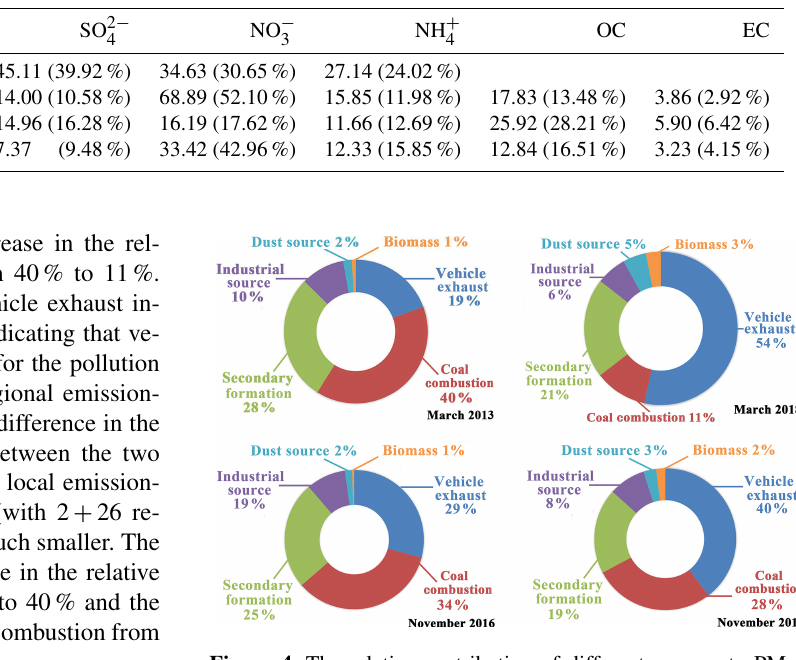
Figure 4. The relative contribution of different sources to PM 2 . 5 concentrations in Beijing during four pollution